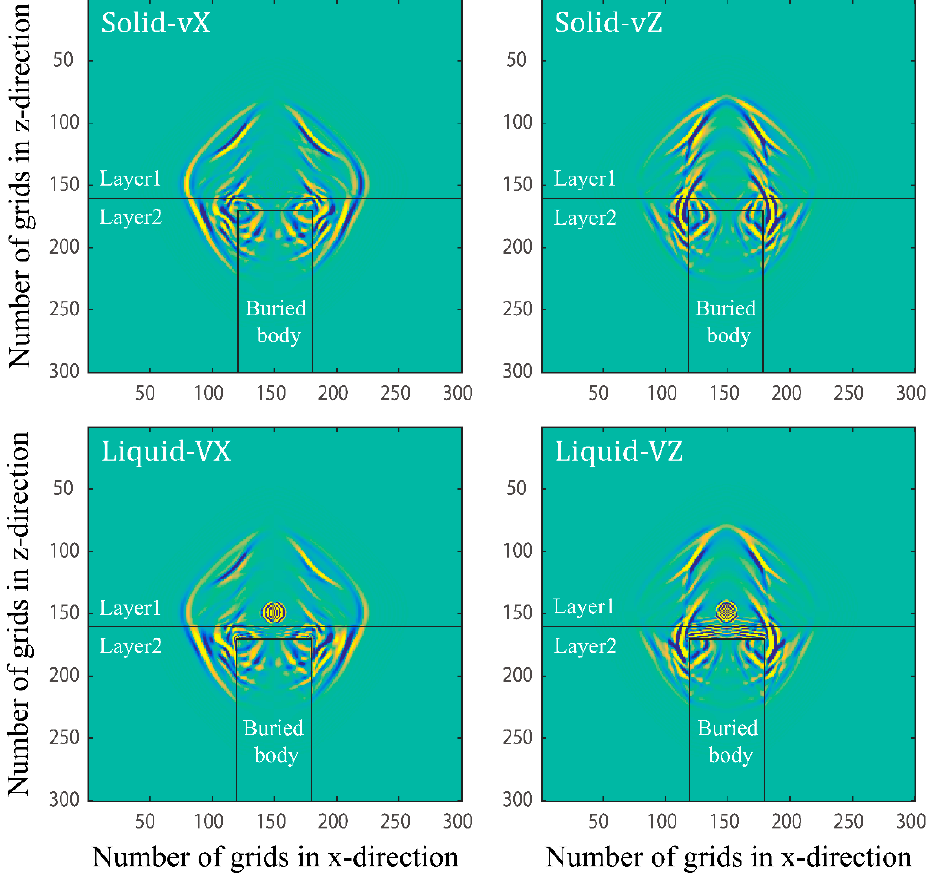
Figure 9. Snapshots of the double layers model with buried body at t = 0.15s . Fast quasi ‐ P, fast quasi ‐ S1, slow quasi ‐ S1, and slow quasi ‐ P waves are reflected,